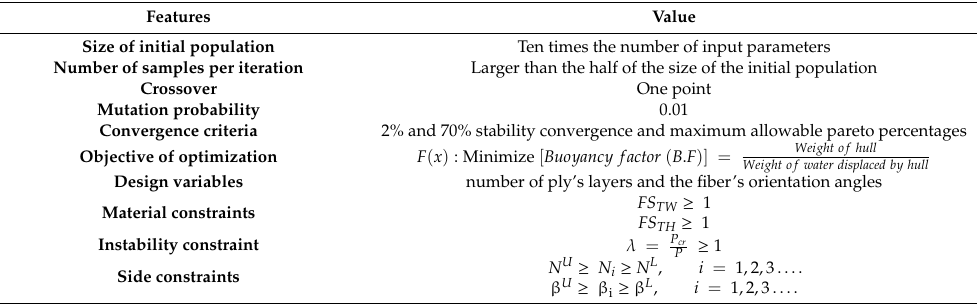
Table 2. Main features of the GA used in this